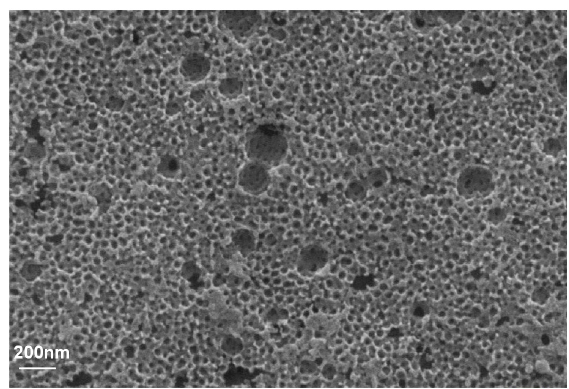
Figure 3. Scanning electron microscopy (SEM) image of the nanostructured 6061-T6 MLA mold.